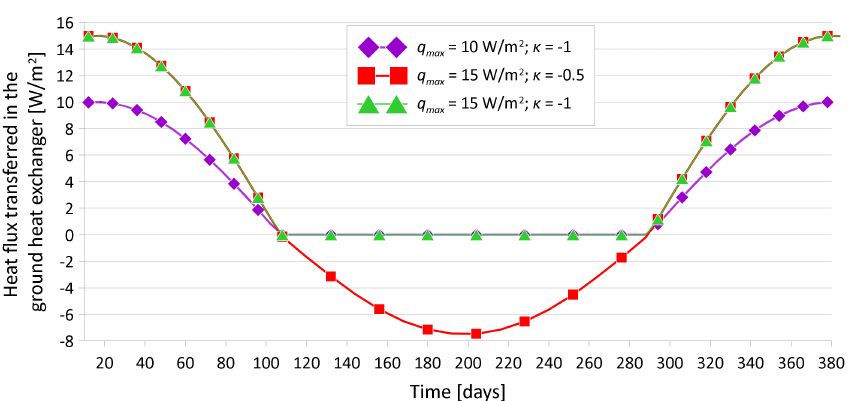
Figure 1. Heat flux transferred in the ground heat exchanger depending on time and parameters q max and κ